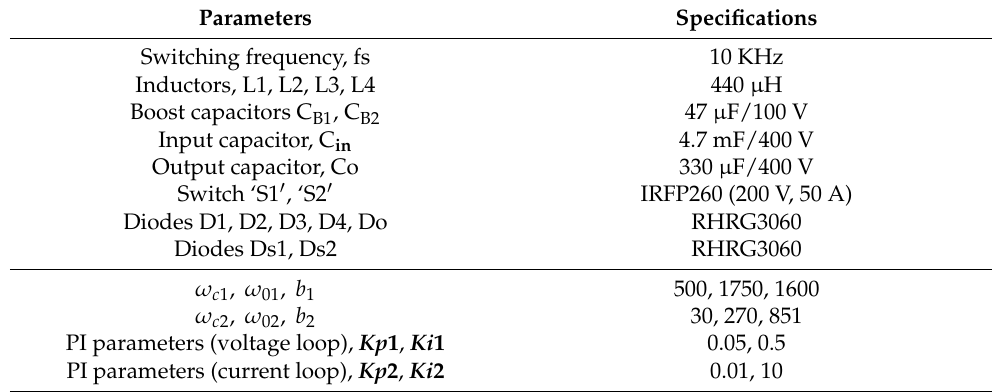
Table 2. Experimental parameters.